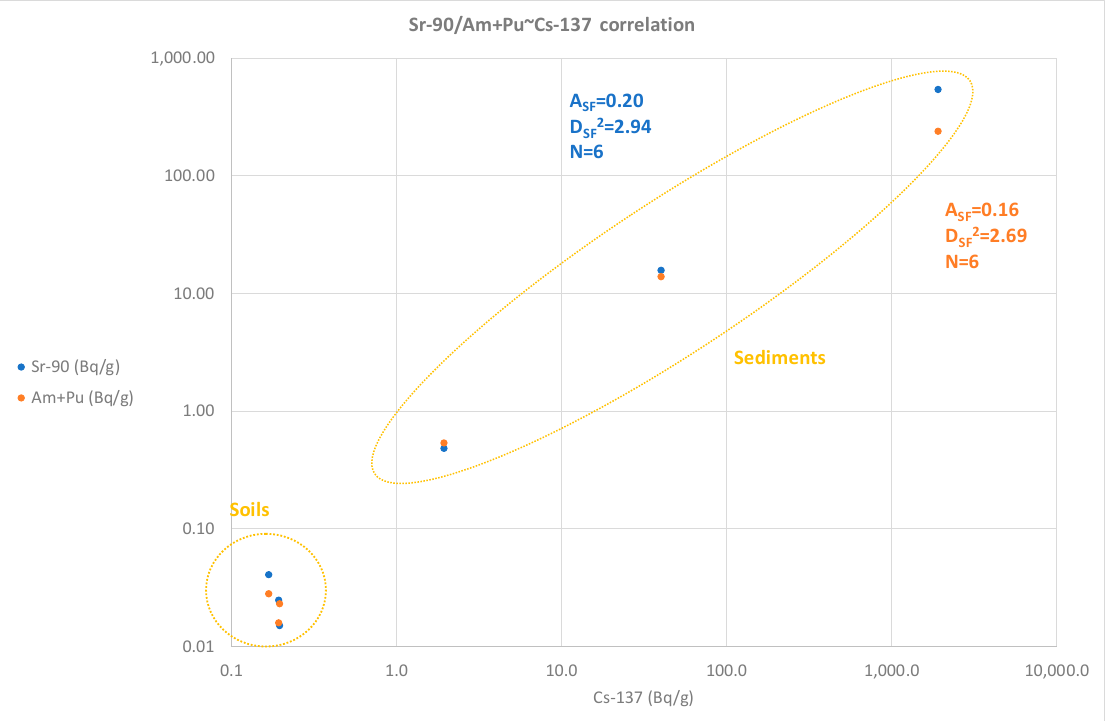
Figure 8. Sr-90/Am + Pu~Cs-137 correlation present in the Saluggia “LivaNova” nuclear installation soils and sediments samples.